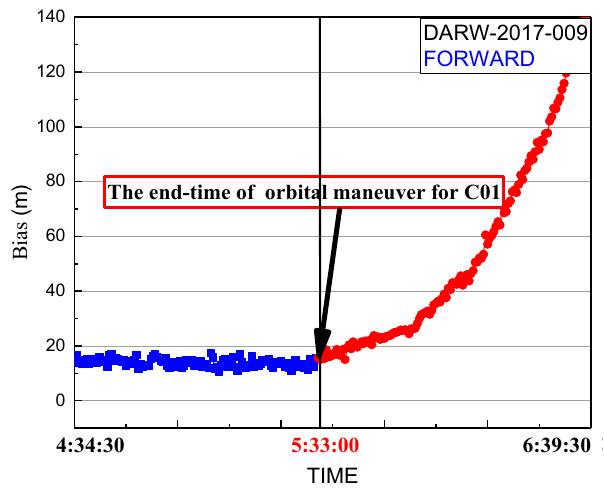
Figure 9. Spatial bias of pseudo-range SPP coordinates for 9 January 2017. Coordinates are calculated by forward predicted orbit using the precise products on the day before orbital maneuvers. The blue line is the series before the end time determined of maneuvering. The red line is the series after the end time determined of maneuvering.